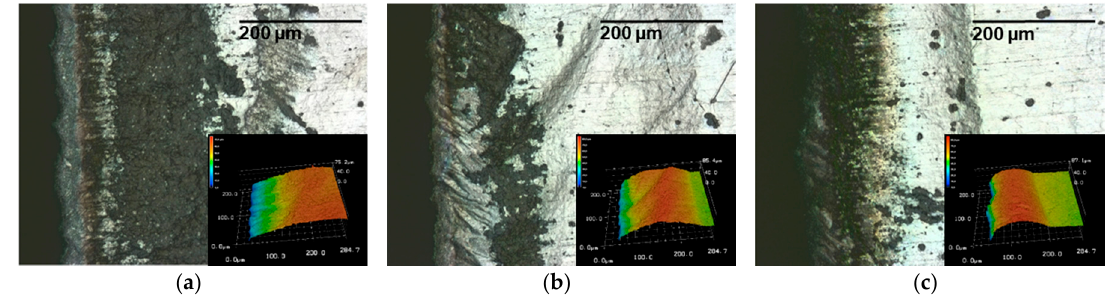
Figure 13. Light and laser scanning microscope sections of a laser cut lithium sheet: 72.8 W, 490 kHz, 240 ns, dew point − 15 °C; ( a ) 50 mm/s, PO 99.89%; ( b ) 100 mm/s, PO 99.77%; ( c ) 150 mm/s, PO 99.66%.